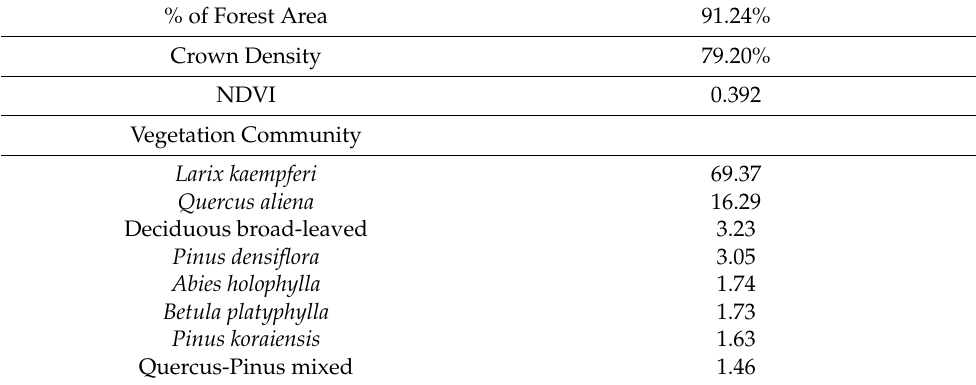
Table 3. Site forest